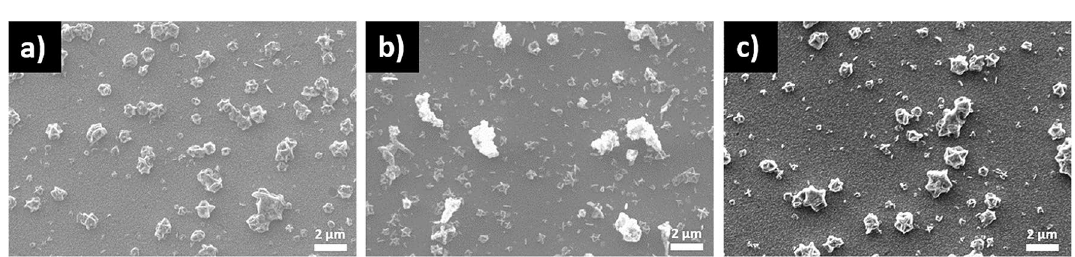
Figure 9. Surface SEM images of the SLG\SnS 2 \Cu stack annealed in S atmosphere. The samples were sulfurized at ( a ) 300, ( b ) 350, ( c ) 375, ( d ) 400 and ( e ) 500 °C.